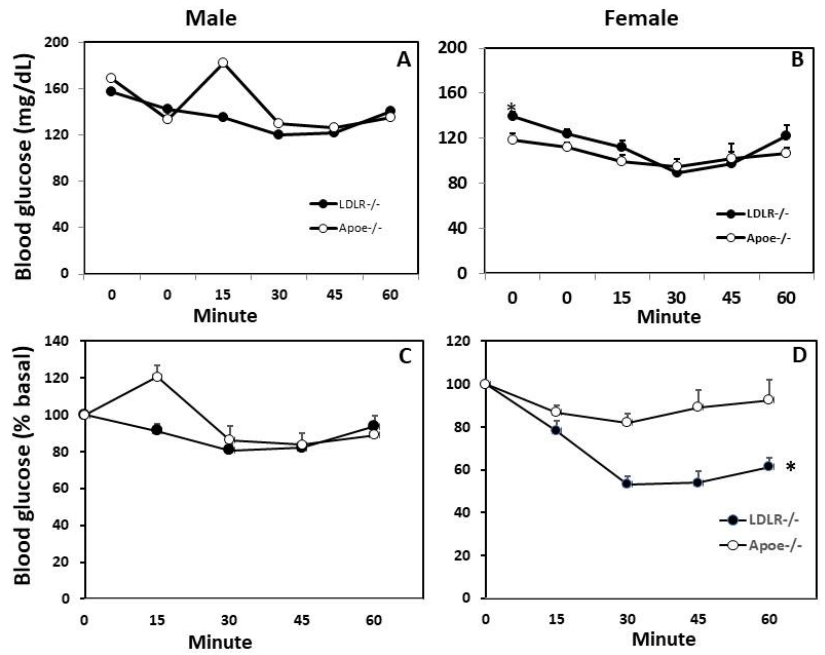
Figure 5. Insulin tolerance test (ITT) for male and female C3H- Apoe -/- and C3H- Ldlr -/- mice fed a Western diet. Non-fasted mice were intraperitoneally injected with 0.75 U/kg of insulin. Blood glucose concentrations were determined with a glucometer using blood taken from cut tail tips at the indicated time points ( A , B ). Values are means ± SE of 4 to 20 mice per group. * p < 0.05 vs. Apoe -/- mice. ( C , D ), Glucose concentrations were expressed as % of the basal.